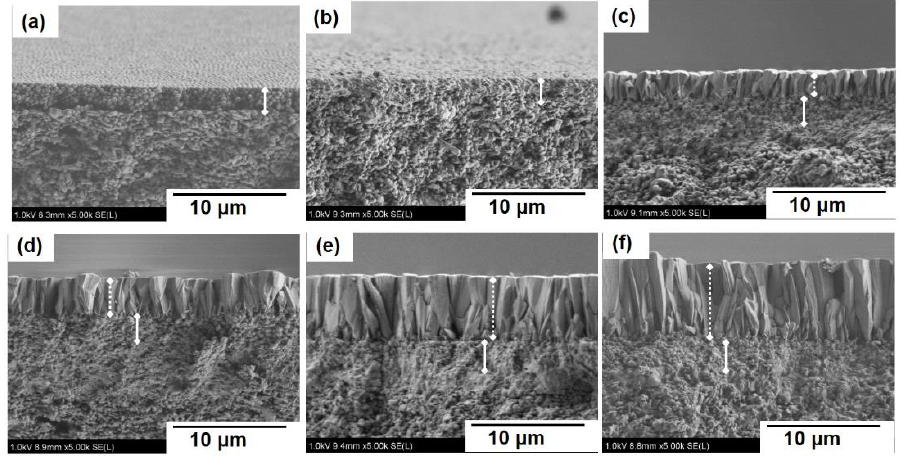
Figure 2. Typical FE-SEM images of cross-section of ( a ) a seeded support and silicalite-1 membranes crystallized for ( b ) 72, ( c ) 120, ( d ) 168, ( e ) 252, and ( f ) 336 h.